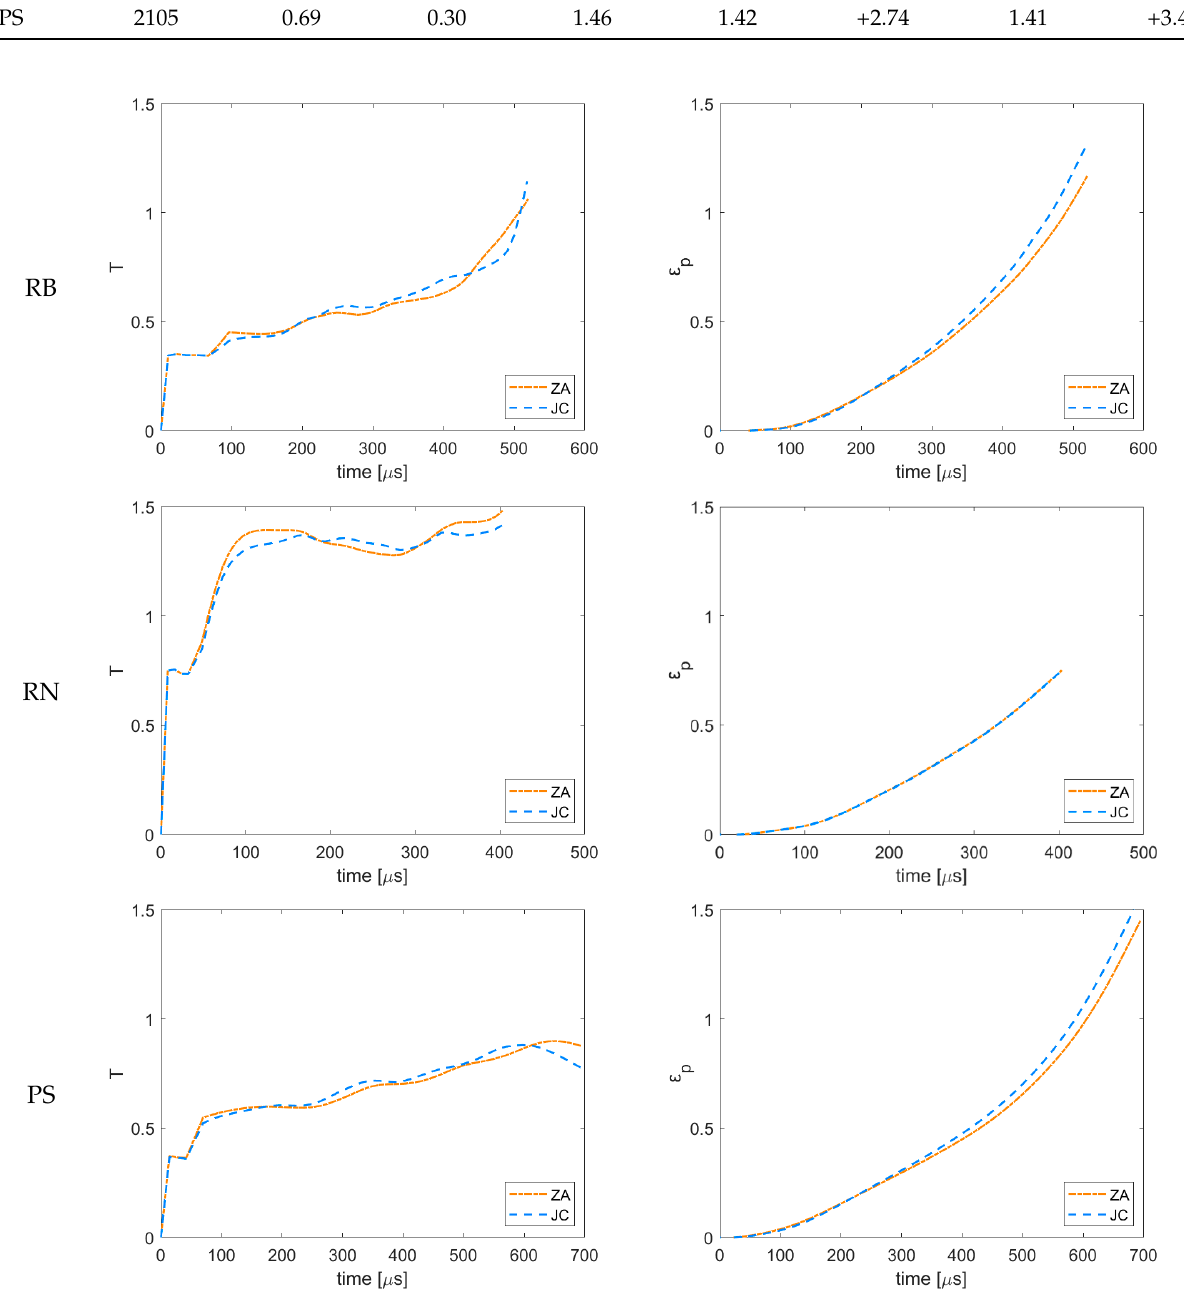
Figure 10. Evolution of triaxiality and equivalent plastic strain computed with the ZA and JC mod- els.